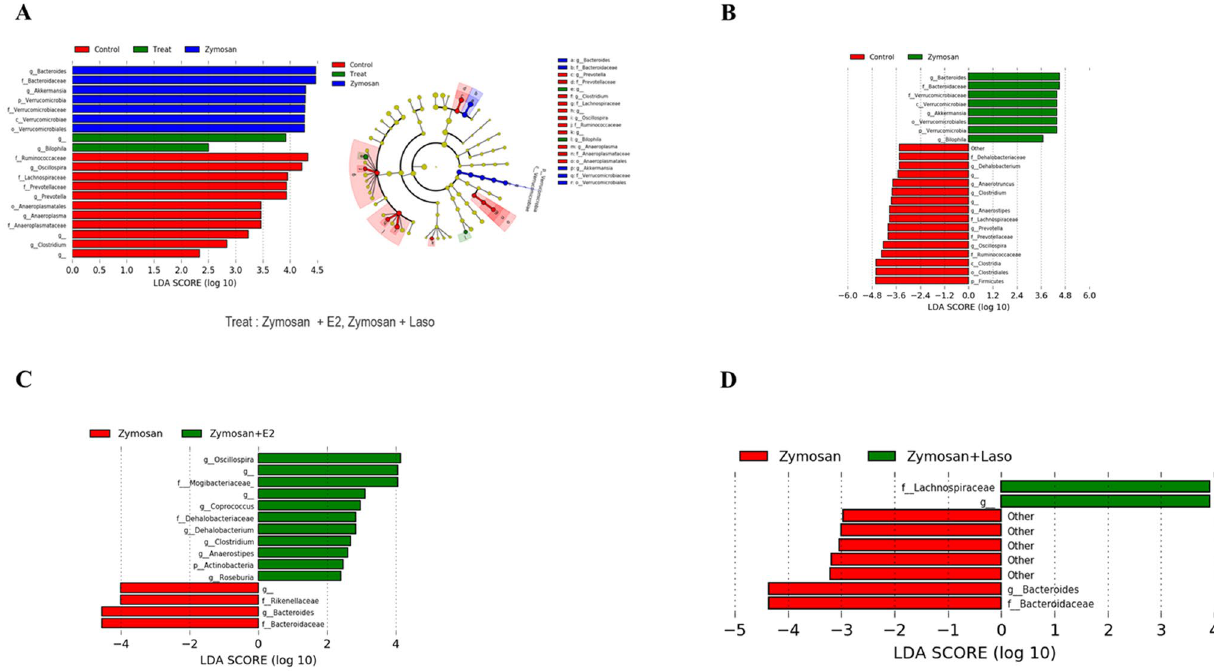
Figure 6. Linear discriminant analysis (LDA) effect size analysis identified the taxa with the greatest differences in abundance between groups. ( A ) LDA effect size analysis of subjects with control, treat, and zymosan (Z) treated group. Treat group refers to both Z + 17β-estradiol (E2) and Z + lasofoxifene (Laso) treated group. Cladogram shows the relationships among differentiating taxa between groups. ( B ) Taxa enriched in control group are indicated by a negative LDA score (red), and Z group enriched taxa are indicated by a positive score (green). ( C ) Taxa enriched in Z group are indicated by a negative LDA score (red), and taxa enriched in Z + E2 treated group are indicated by a positive LDA score (green). ( D ) Taxa enriched in Z group are indicated by a negative LDA score (red), and taxa enriched in Z + Laso treated group are indicated by a positive LDA score (green). The significant log LDA score > 2.0 for all taxa. Analysis were performed using QIIME2 software (https:// qiime2. org) and LEfSe (https:// twbat taglia. gitbo oks. io/ intro ducti on- to- qiime/ conte nt/ lefse. html). g genus, f family, o